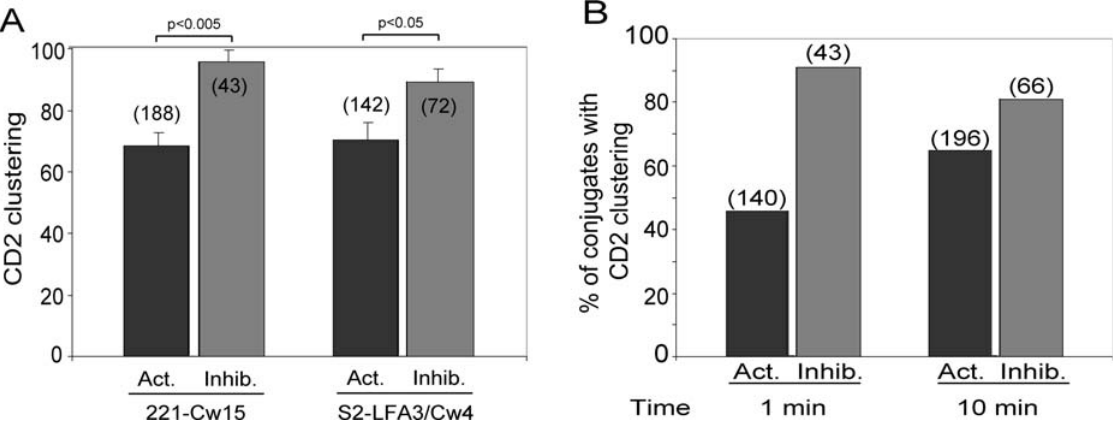
Figure 3. CD2 accumulates more frequently at inhibitory synapses than at activating synapses. (A) Conjugates between IL-2 activated polyclonal human NK cells and 721.221-Cw15 cells or S2–LFA-3/Cw4 cells were formed and stained as in Figure 2. Activating (Act.) and inhibitory (Inhib.) synapses were scored for clustering of CD2 at the zone of contact. The number of conjugates scored in each condition is indicated in parentheses. (B) Conjugates between activated NK cells and 721.221-Cw15 cells were allowed to form for 1 minute or 10 minutes as indicated, stained with the cyt42/43 antiserum and an anti-CD2 antibody as in Figure 2, and scored for CD2 clustering.